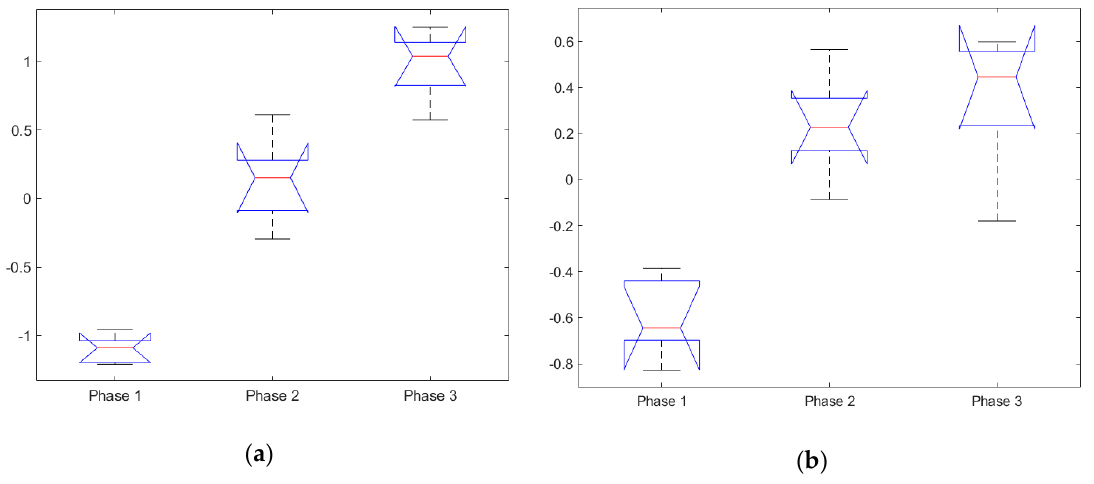
Figure 5. ( a ) Mean task index of all participants (normalized), grouped by the scenario phase and ( b ) mean controller input count of all participants (normalized), grouped by the scenario phase.